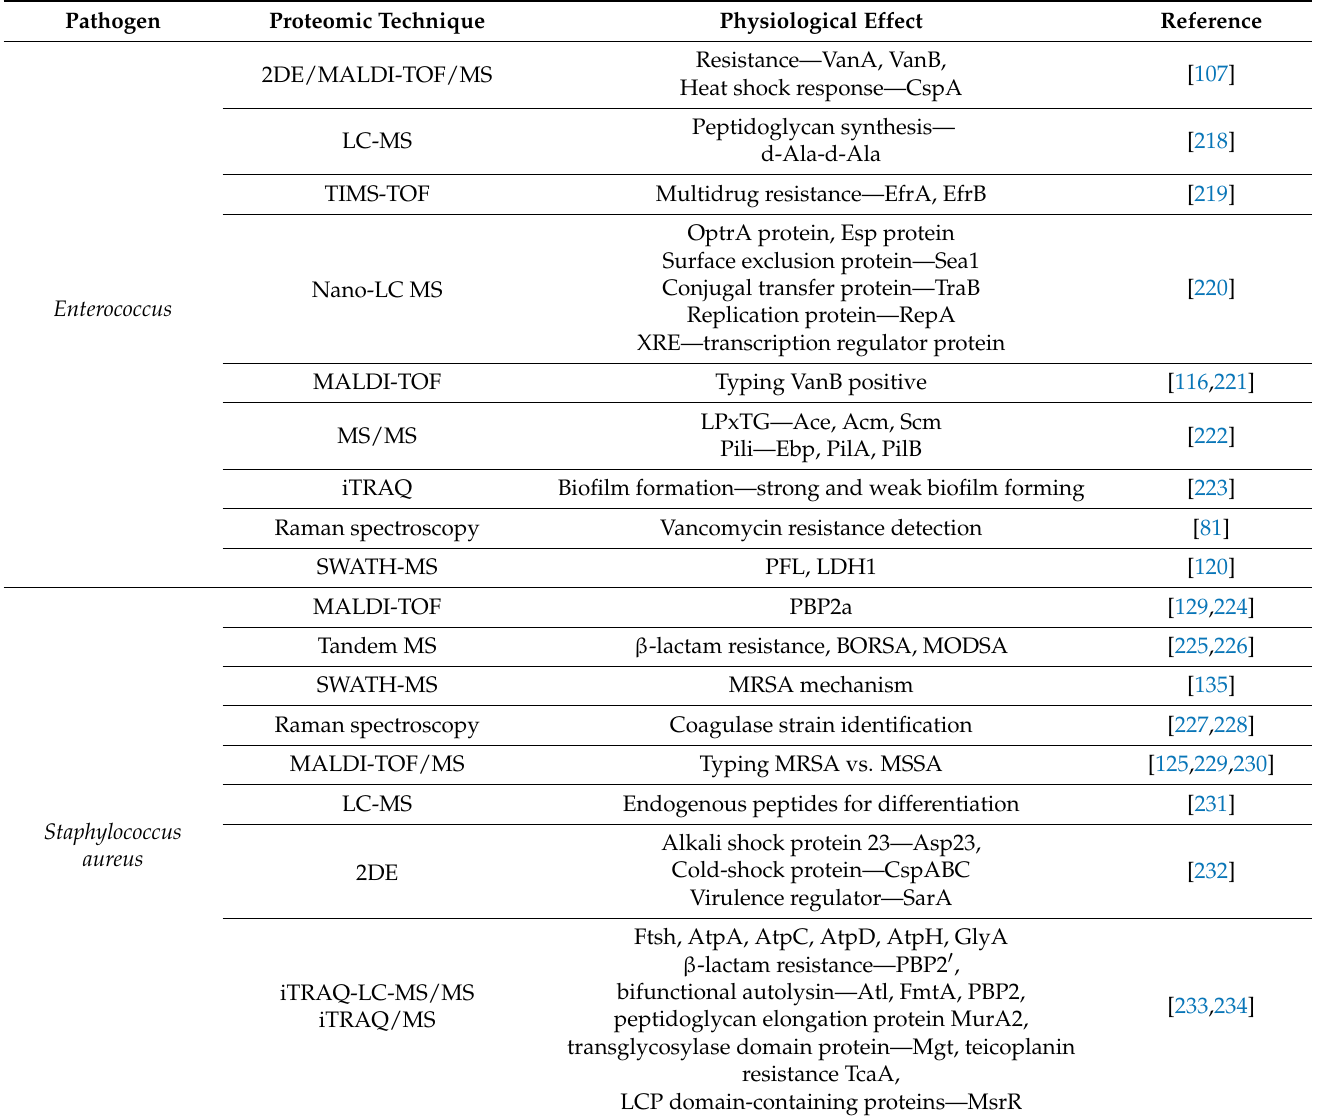
Table 1. Proteomic techniques for ESKAPE